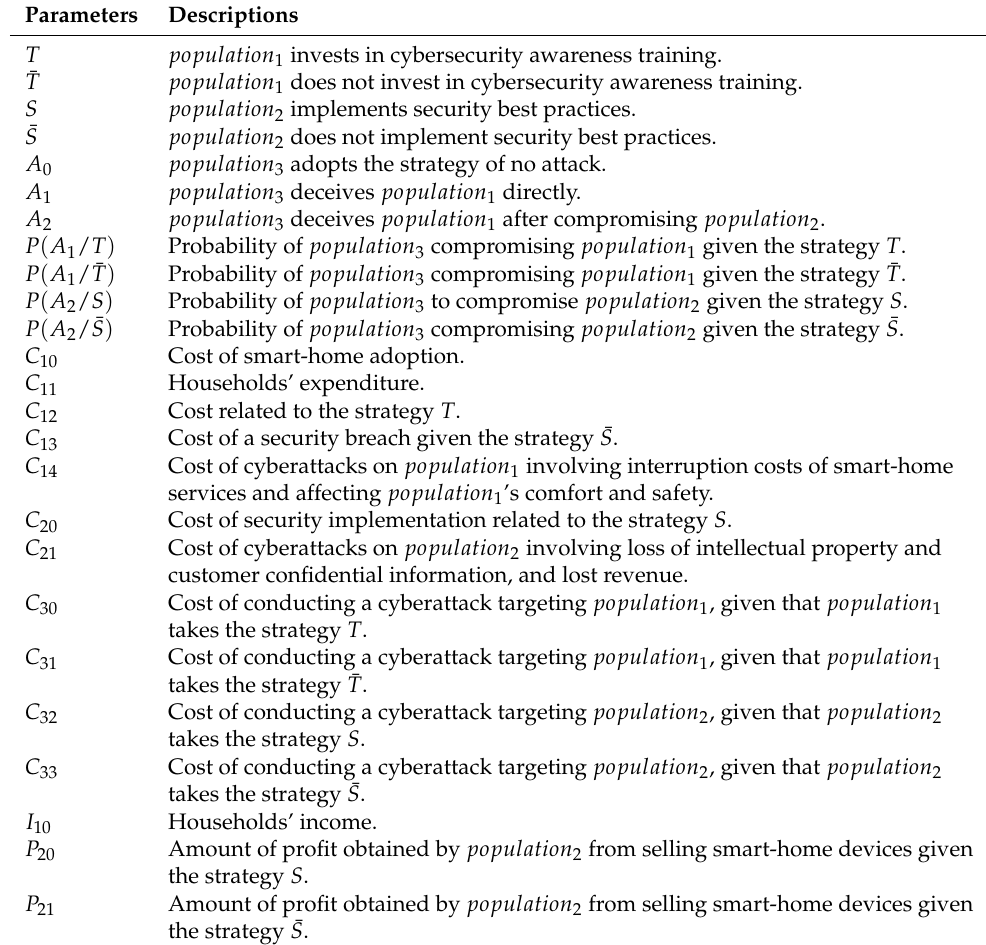
Table 2. List of parameters used in the proposed evolutionary game